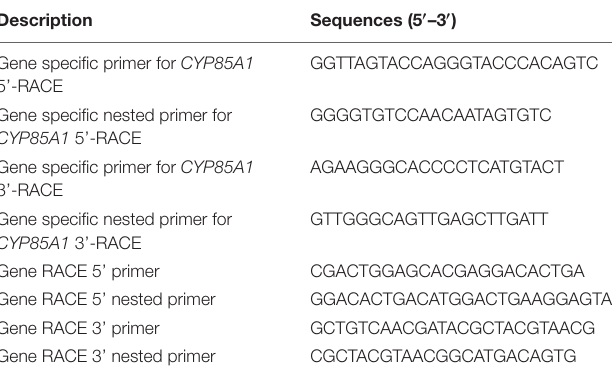
TABLE 1 | Sequences of specific primers and nested primers in cloning SoCYP85A1.